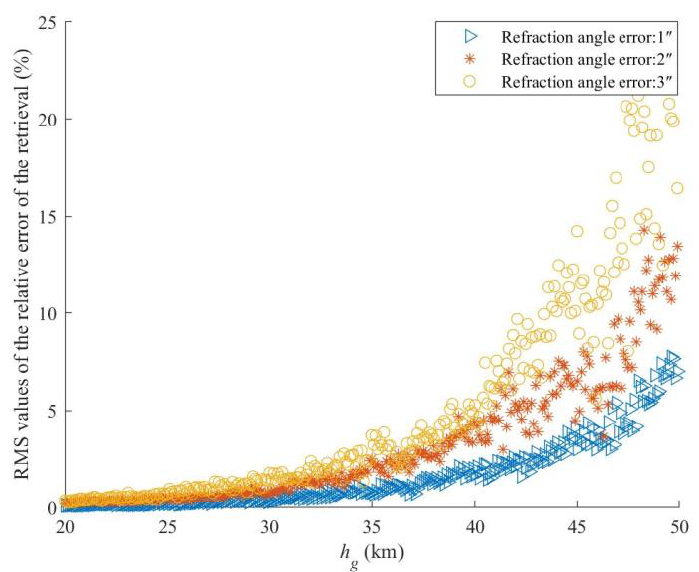
Figure 13. Relative error of the retrieval due to the refraction angle error with the tangent height.